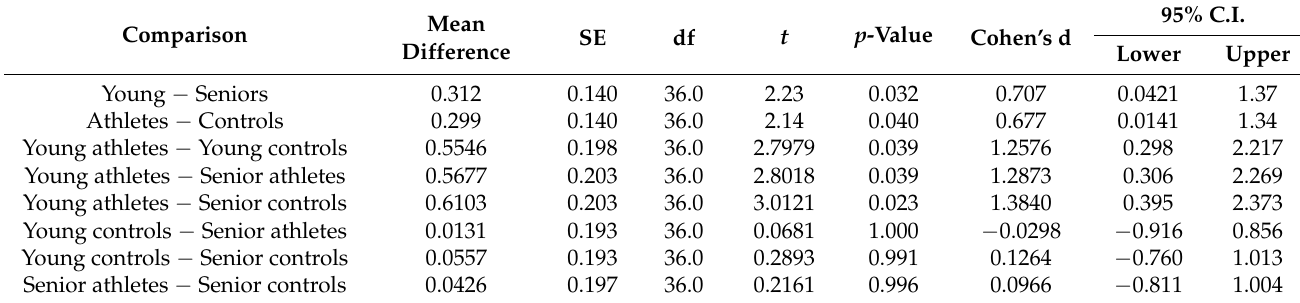
Table 5. ANOVA results for maximum ground reaction forces.